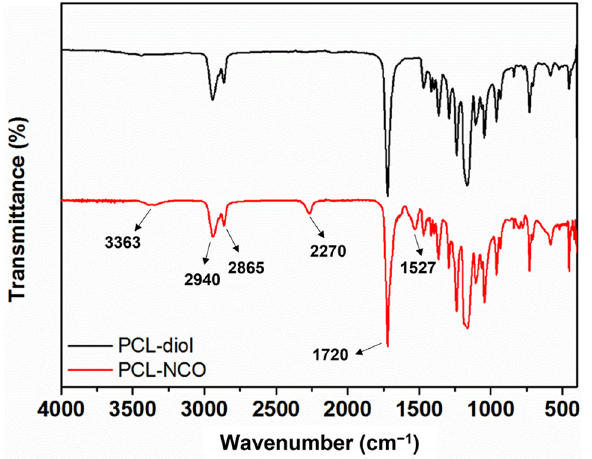
Figure 2. FTIR spectra of the PCL diol and PCL-NCO.